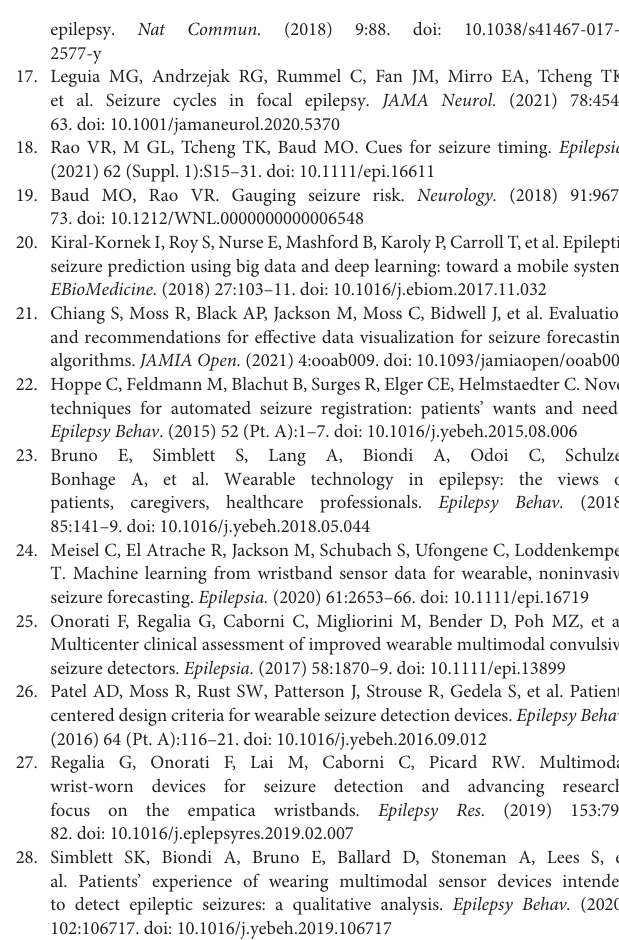
Supplementary Table 1 | Survey Questionnaire. List of questions and logic flow of the survey